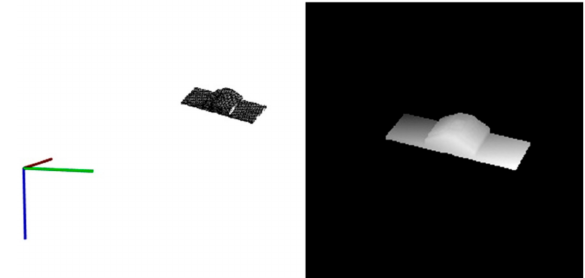
Figure 3. The point cloud data in 3D view ( left ) and the converted depth map ( right